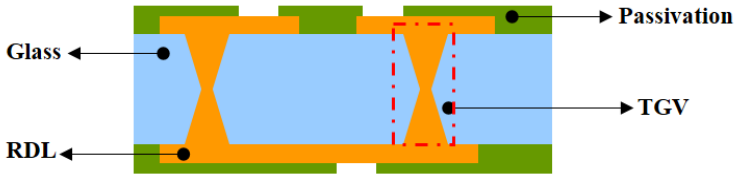
Figure 1. Three-dimensional interconnection structure with TGV.